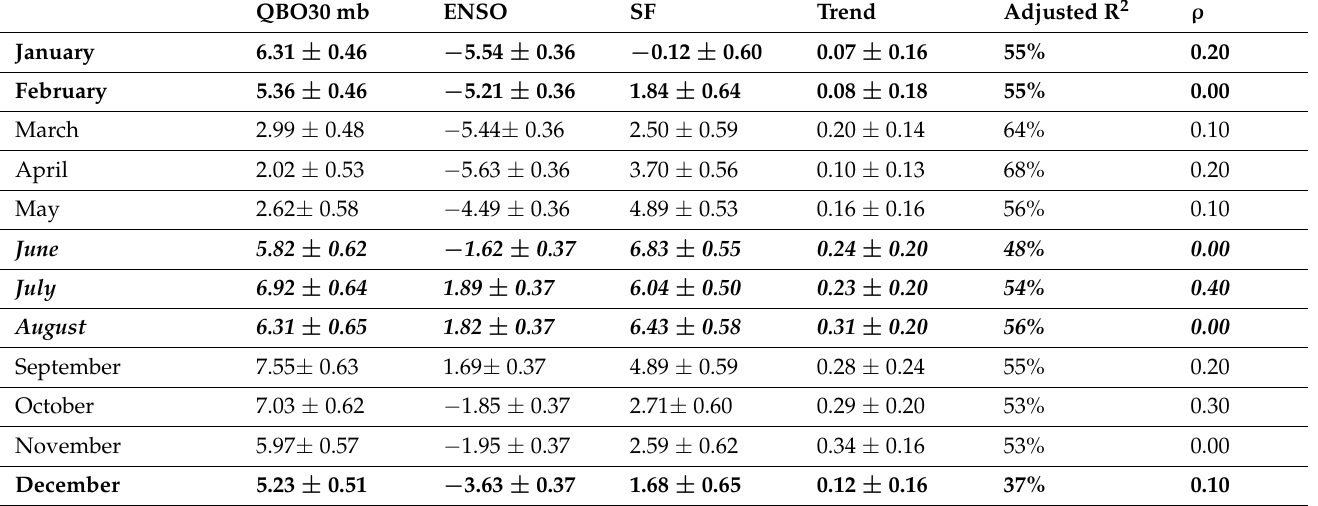
Table 4. Contribution of forcings (QBO30, ENSO, and SF) in the DU and trends after 1997 in the DU year − 1 for each month. Values are given at 2 σ . Bold lines refer to harmattan months while bold and italic lines refer to monsoon months in Togo. Adjusted R 2 represents the percentage of the variability explained by the model after the Cochrane–Orcutt transformation and ρ is the autocorrelation